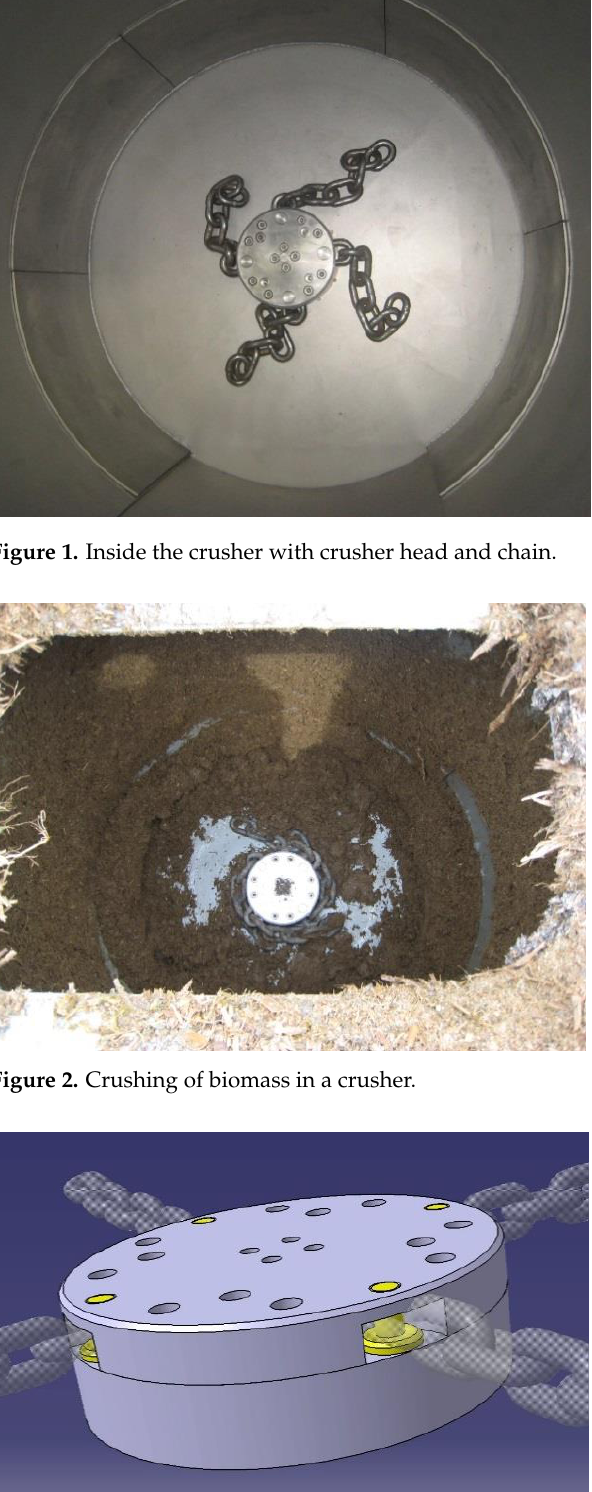
Figure 3. Crusher head with chain attachment.